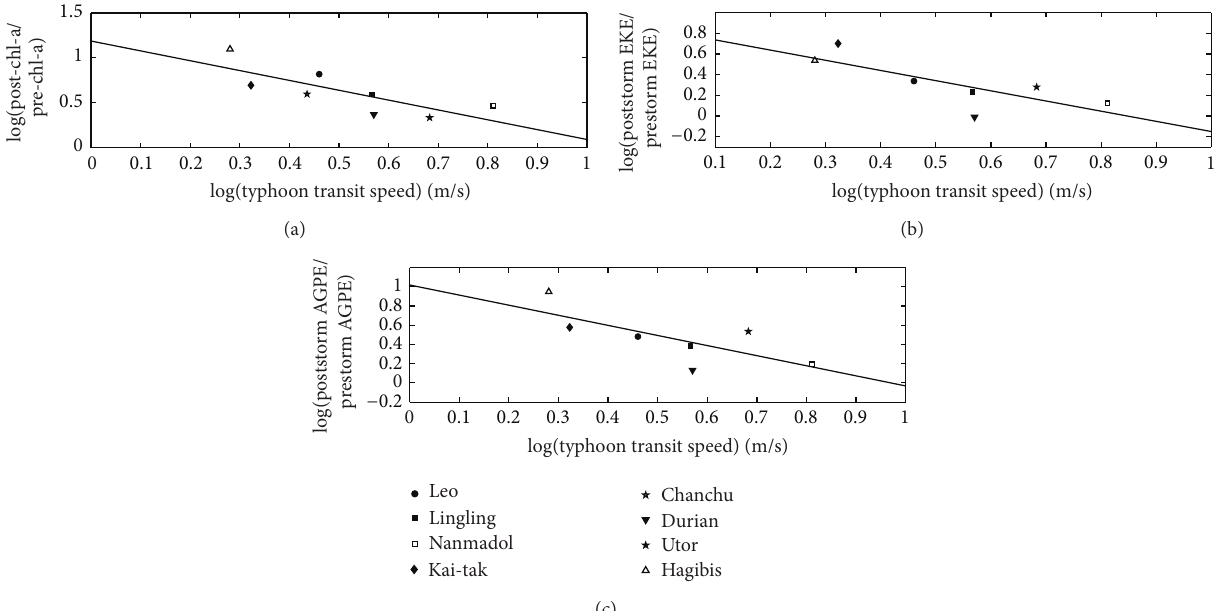
Figure 10: The ratio of poststorm (a) chl-a, (b) EKE, and (c) EAGPE to prestorm chl-a, EKE, and EAGPE, respectively, versus typhoon transit speed in logarithm